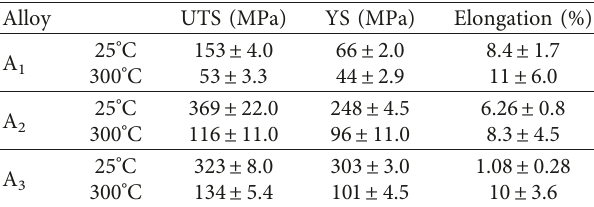
Table 3: Tension properties at 25 ° C and 300 ° C of the studied alloys T6